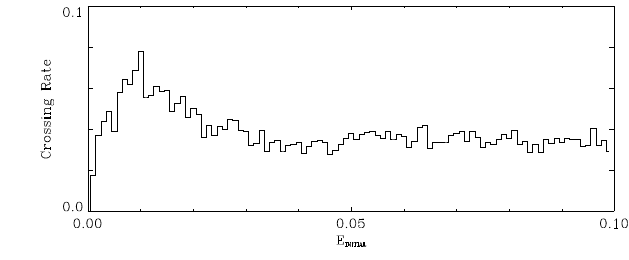
Fig. 5. Number of escaping particles depending on initial